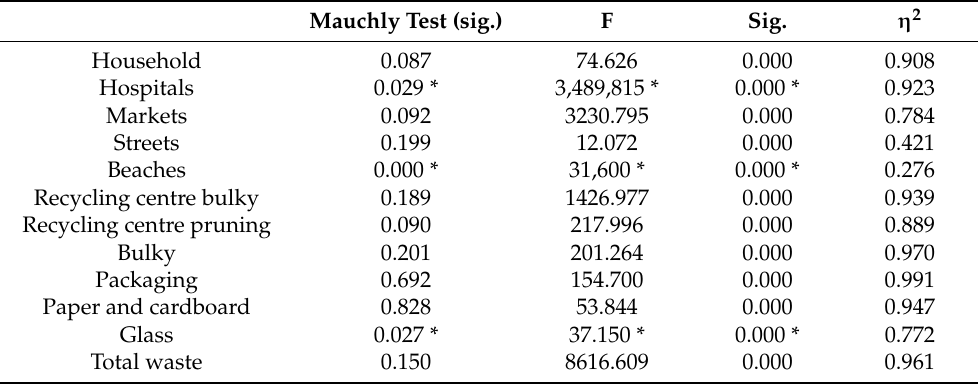
Table 3. RM ANOVA.